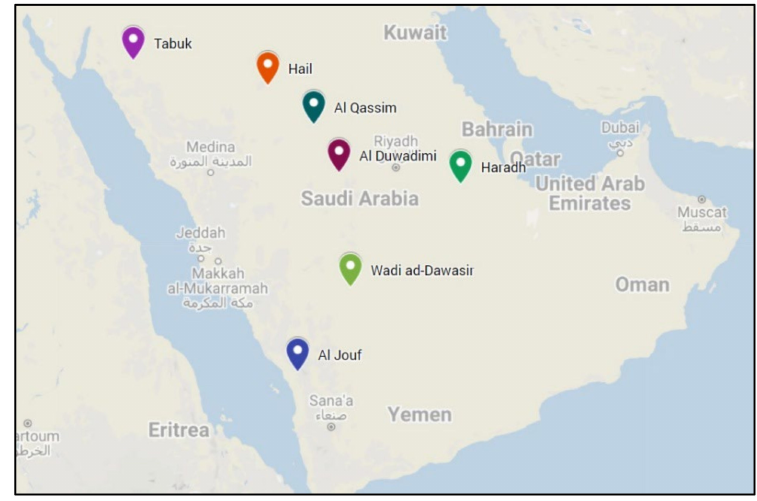
Figure 1. The different sites from which the Ryegrass genotypes were collected. Table 1. List of Lolium genotypes estimated by different herbicides rate